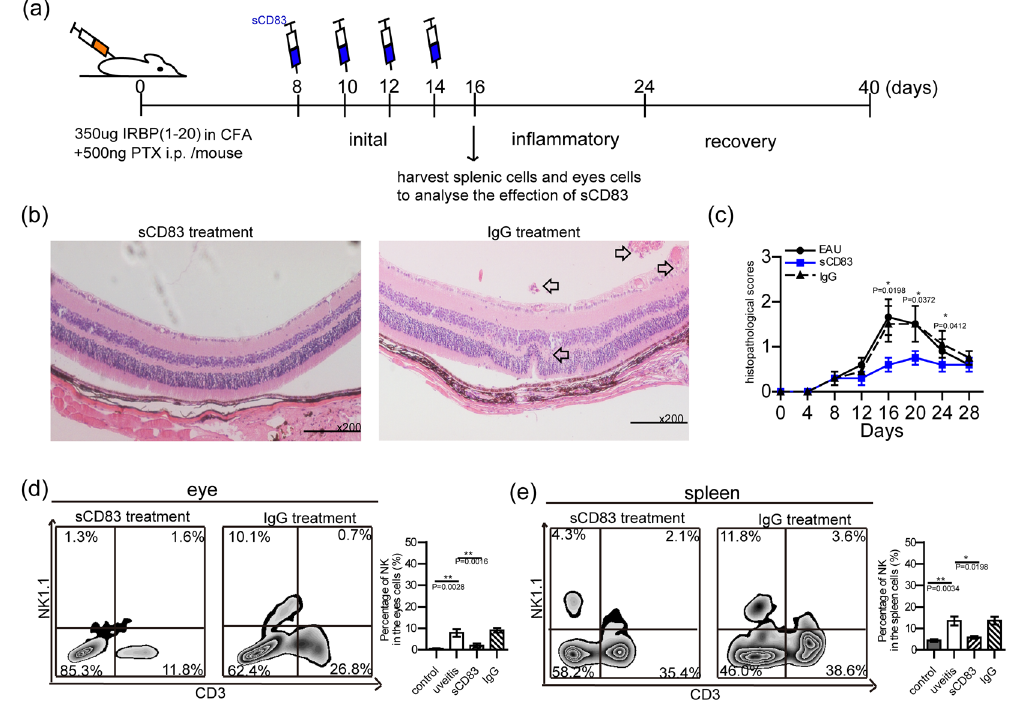
Figure 2. sCD83 treatment decreased pathological injury and percent of NK cells within inflamed eyes. ( a ) Mice were immunized on day 0 and treated with sCD83 on days 8, 10, 12, 14 with 10 μ g sCD83 by intravenous injection. At 16 days after immunization, eyes of the mice following a treatment with sCD83 or IgG were harvested for H&E staining. ( b ) Histopathological analysis of a representative eye section from an EAU mouse treated with sCD83 or IgG. Infiltrating lymphocytes, vasculitis and photoreceptor folding within the retina were found in the eye with IgG treatment (hollow arrows). ( c ) Analysis of histopathological scores in the development of uveitis disease in EAU mice with or without sCD83 treatment or with IgG treatment. No statistically significant differences were obtained between EAU and IgG-treated-EAU mice. Statistically significant differences in histopathological scores were obtained between EAU and sCD83-treated-EAU mice on days 16, 20 and 24 (a total of twenty-four mice/group were used and the experiments were replicated three times, values represent the mean ± s.e.m, * P < 0.05). With sCD83 treatment, the percent of CD3-NK1.1 + cells from inflamed eyes ( d ) and spleen ( e ) were measured (A total of ten mice/group were used and experiments were replicated three times, values represent the mean ± s.e.m., * P < 0.05, ** P <